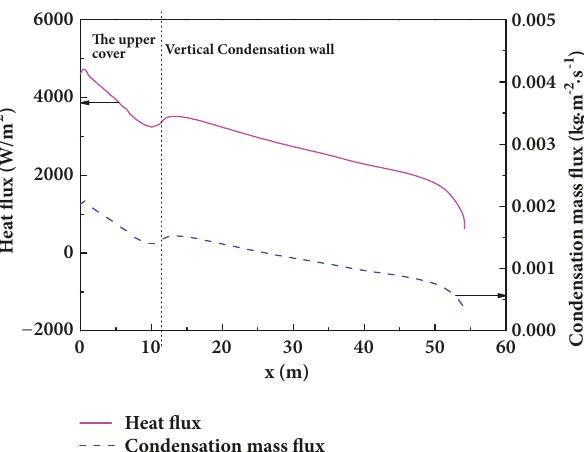
Figure16:Thedistributionsofheatfluxandcondensationmassflux.